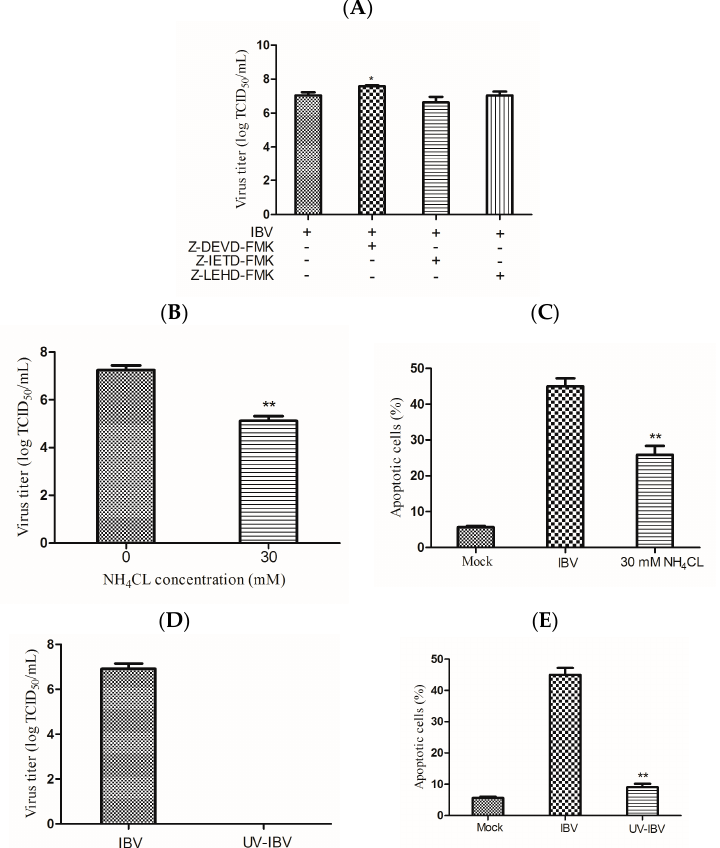
Figure 5. Interplay between cell apoptosis and virus replication. ( A ) Following incubation with inhibitors for 2 h, the cells were infected with IBV Beaudette of 10 MOI for 36 h. After pre-treatment, virus titers were determined as log TCID 50 /mL. Data are shown as the mean ± SEM. * p < 0.05 versus virus infection alone. ( B , C ) A 30 μ M concentration of NH 4 Cl was used to incubate HD11 cells for 2 h before infection, then cells were infected with IBV Beaudette of 10 MOI for 36 h, and the virus titer ( B ) and the rate of apoptotic cells ( C ) were separately tested. Data are shown as the mean ± SEM. ** p < 0.01 versus cells infected without NH 4 Cl. ( D , E ) UV germicidal light was utilized to inactivate IBV Beaudette for 30 min. UV-inactivated virus infected HD11 cells for 36 h; the virus titer ( D ) and the rate of apoptotic cells ( E ) were measured separately. Data are shown as the mean ± SEM. ** p < 0.01 versus UV-untreated IBV Beaudette.